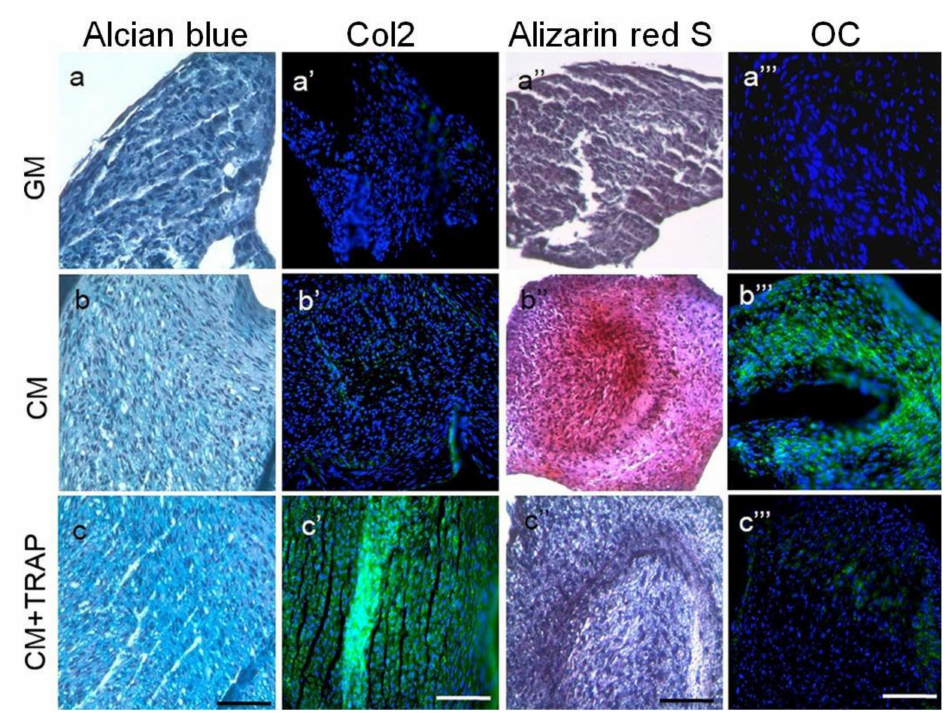
Figure 4. Histology indicates that 10 µ g/ml TRAP promotes chondrogenic differentiation and suppresses hypertrophic mineralization. Labels on individual panels refer to culture media type: ( a – a ”’) GM; ( b – b ”’) CM; ( c – c ”’) CM+TRAP. Note the intense bright blue staining of TRAP-treated cell pellets stained with alcian blue ( c , indicative of glycosaminoglycans present in the ECM) and the corresponding lack of Alizarin red staining ( c ”, indicative of minimal calcium deposition). Note also the green fluorescent staining of TRAP-treated cell pellets immuno-stained with Col2 ( c ’) and the corresponding lack of OCN staining ( c ”’). Alcian blue and alizarin red sections were counter-stained with Harris Haematoxylin (purple nuclei); Col2 and OCN sections were counter-stained with Hoechst dye (blue nuclei). Scale bar 100 µ m. (Reproduced from [38], an open access article distributed